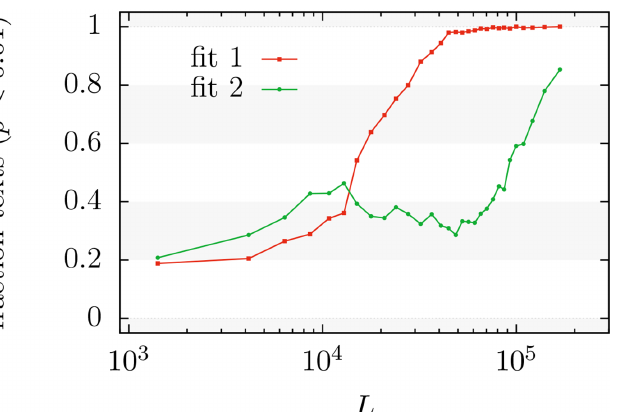
Fig 6. Number of texts with p -value near zero ( p < 0.01) in different ranges of L divided by the number of texts in the same ranges, for the fits of distributions f 1 and f 2 . Values of L denote the geometric mean of ranges containing 1000 texts each. The higher value for the fit of f 1 (except for L below about 13000 tokens) denotes its worst